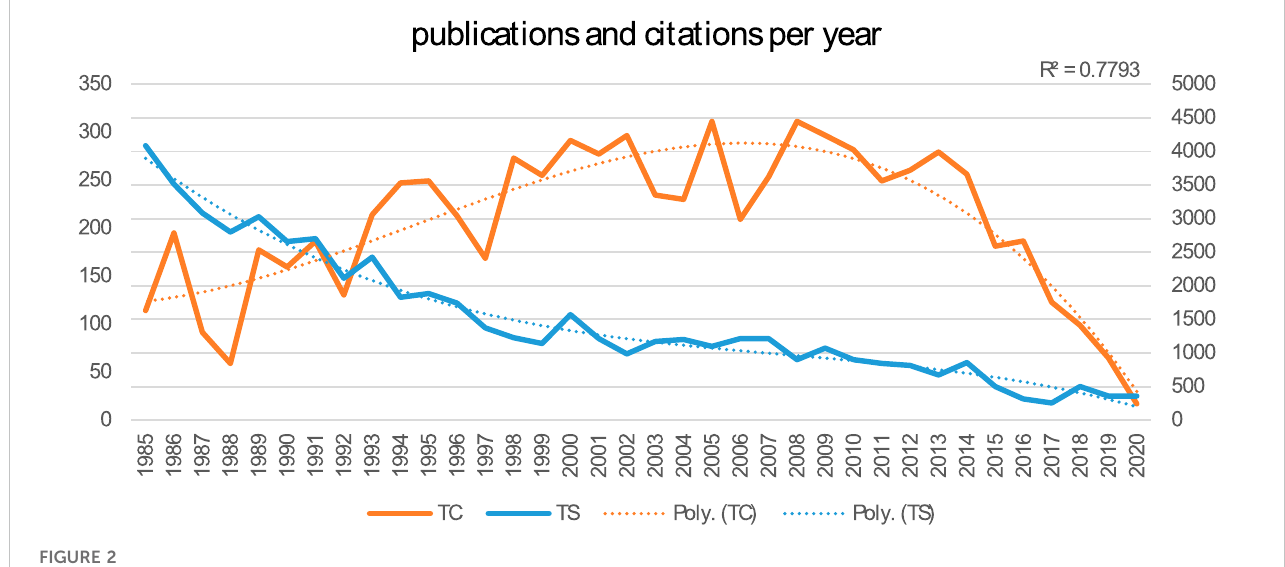
Number of publications and citations per year from 1985 to